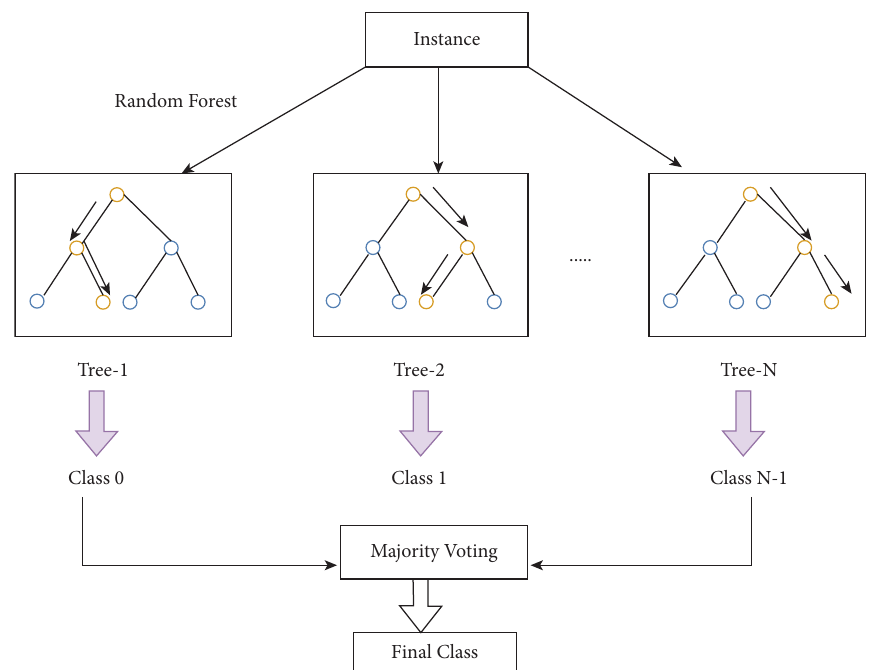
Figure 6: Ensemble of decision tree classifiers in random Table 2: Parameter setting for ML models.